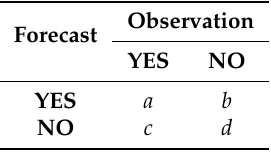
Table 4. Contingency